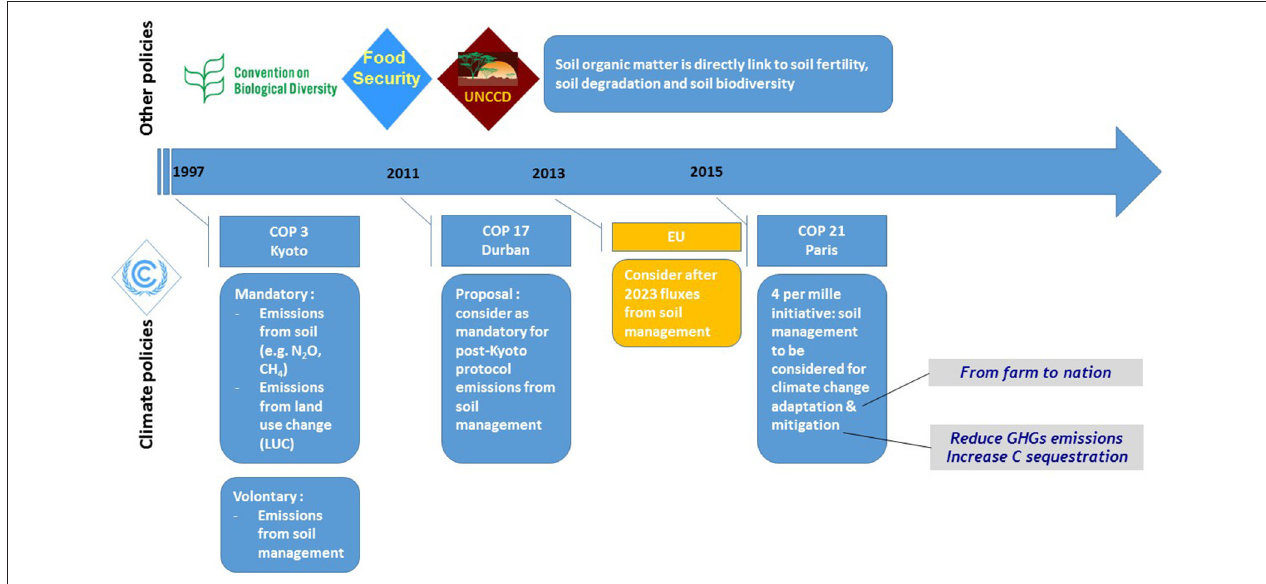
FIGURE 2 | Soil and policies: major